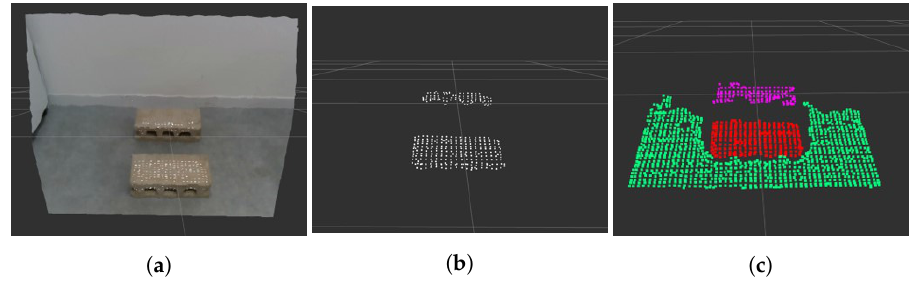
Figure 3. Point cloud results for each method. ( a ) Original; ( b ) RANSAC; ( c ) Euclidean clustering.